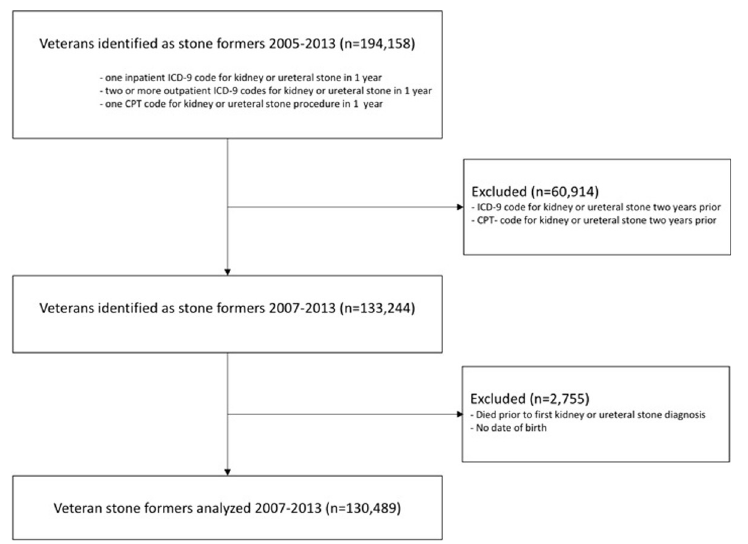
Fig 1. Flow chart showing patient cohort selection and